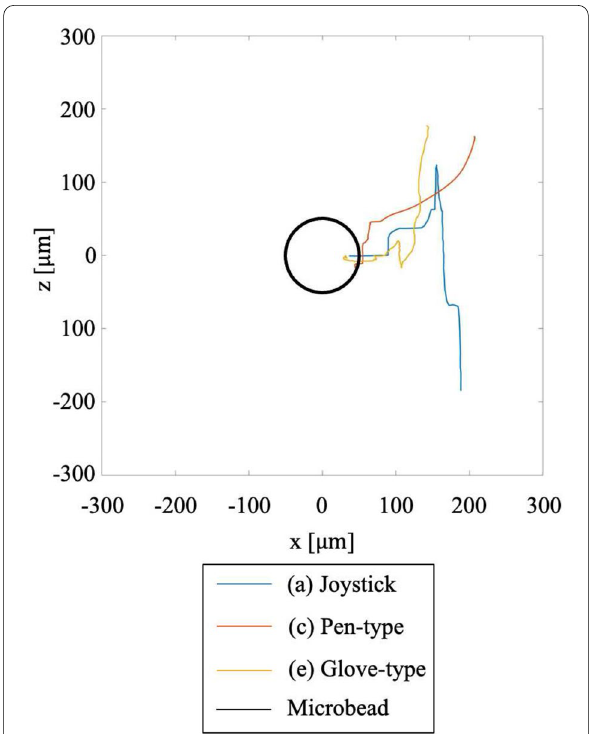
Fig. 22 Trajectories in the yz -plane with 2D image presentation for the evaluation of operation